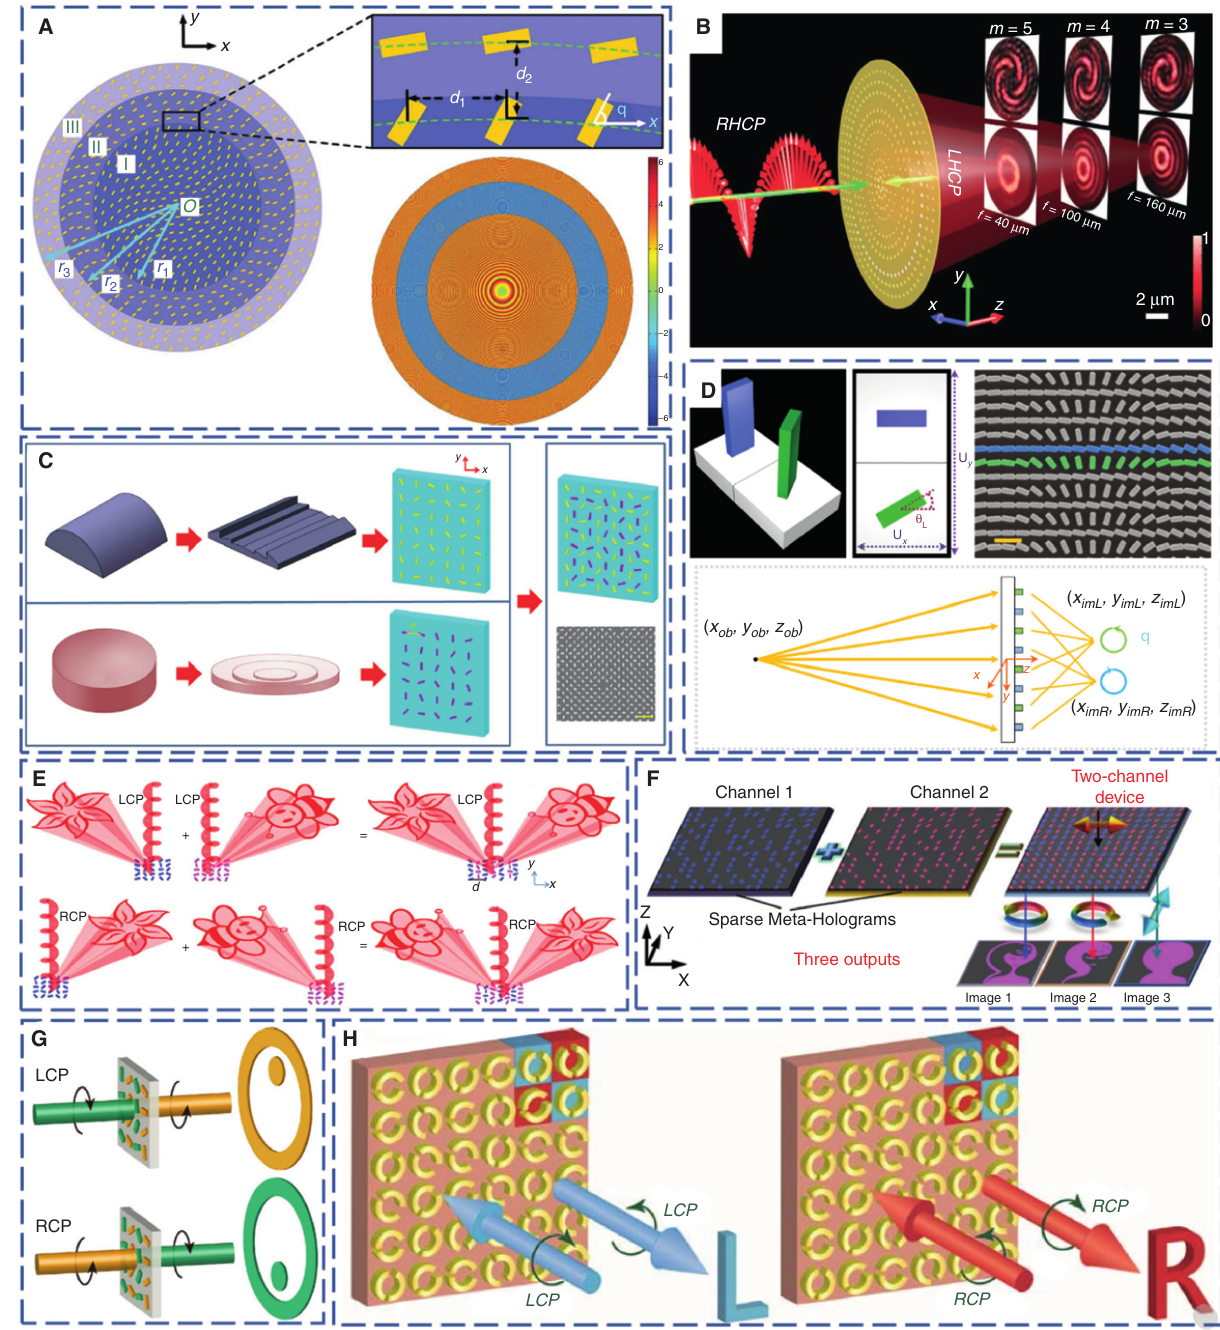
Figure 11: Segmented and interleaved nanostructures for multifunctional and multiplexed metasurfaces. (A) Metalens to produce multifocal spots [86]. (B) Spiral phase plates for generating vortex beams with different topological charges [87]. (C) Integration of cylindrical and spherical metalenses for 1D and 2D Fourier transformation [88]. (D) Integration of dual-off-axis